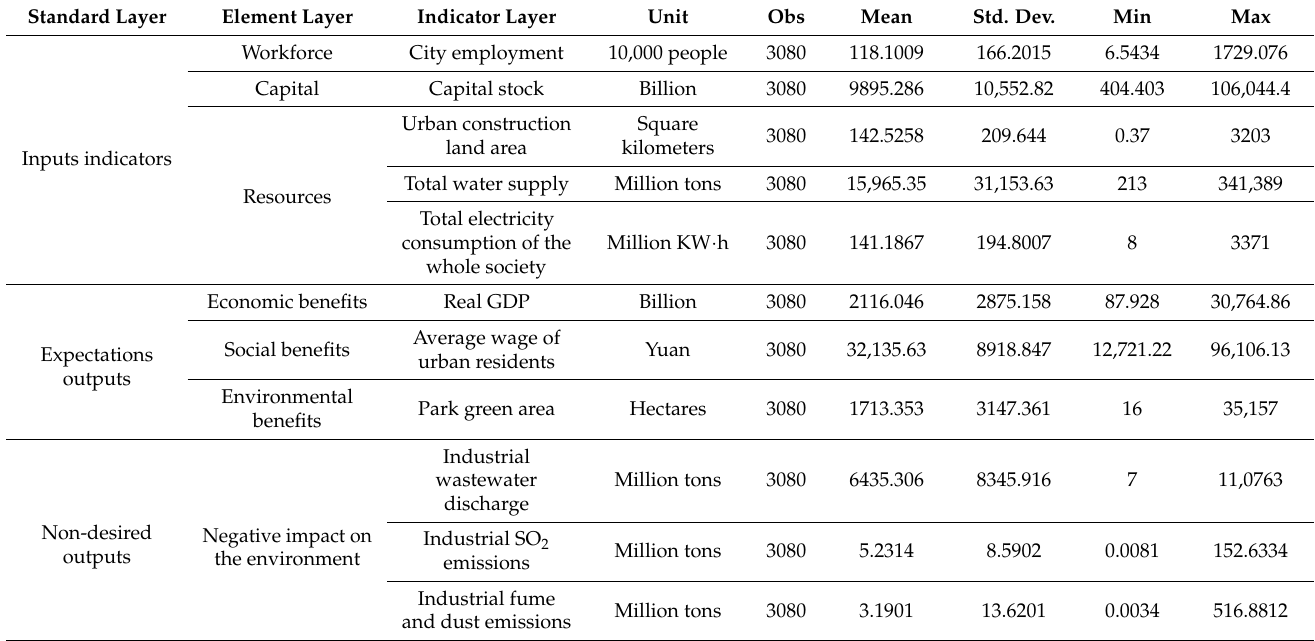
Table 1. Urban green development efficiency input–output indicator system and its descriptive